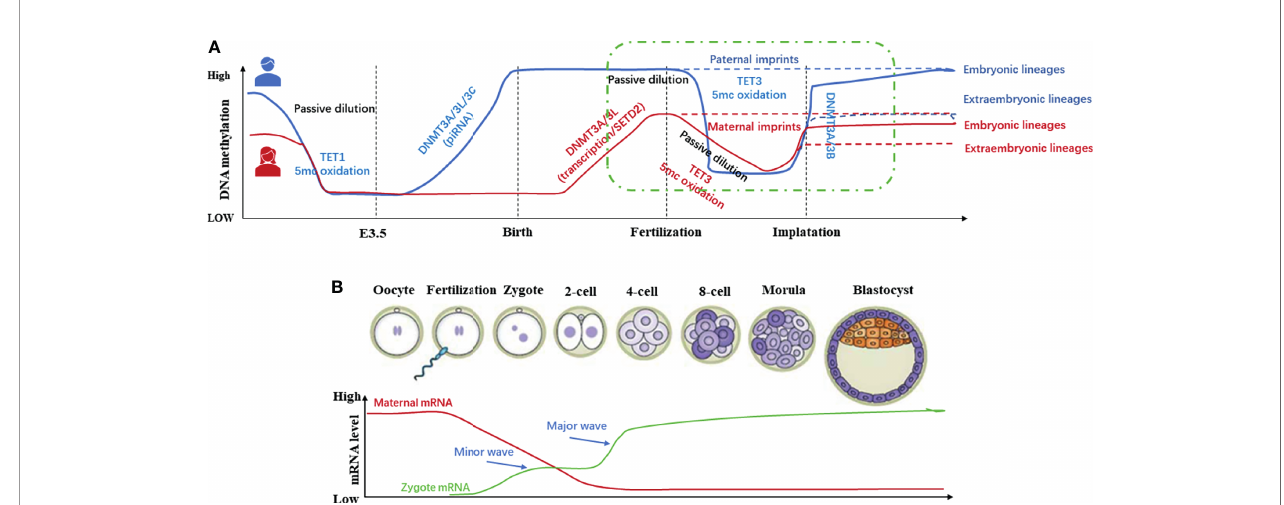
FIGURE 3 | Methylation dynamics of gametes and early embryos during development (11, 29, 30). (A) In the germ line, DNA methylation in Primordial Germ Cells (PGCs) is almost completely eliminated to protect the PGCs from premature differentiation. Before mature gametes are formed, germ cells re-establish DNA methylation in a sex-speci fi c manner. In early embryos, except imprinted genes and certain repetitive sequences, the genome undergoes global demethylation after fertilization and re-methylation after embryo implantation. (B) In general, global DNA methylation is mostly static throughout life. However, two waves of genome-wide DNA demethylation-remethylation occur in the germline and preimplantation